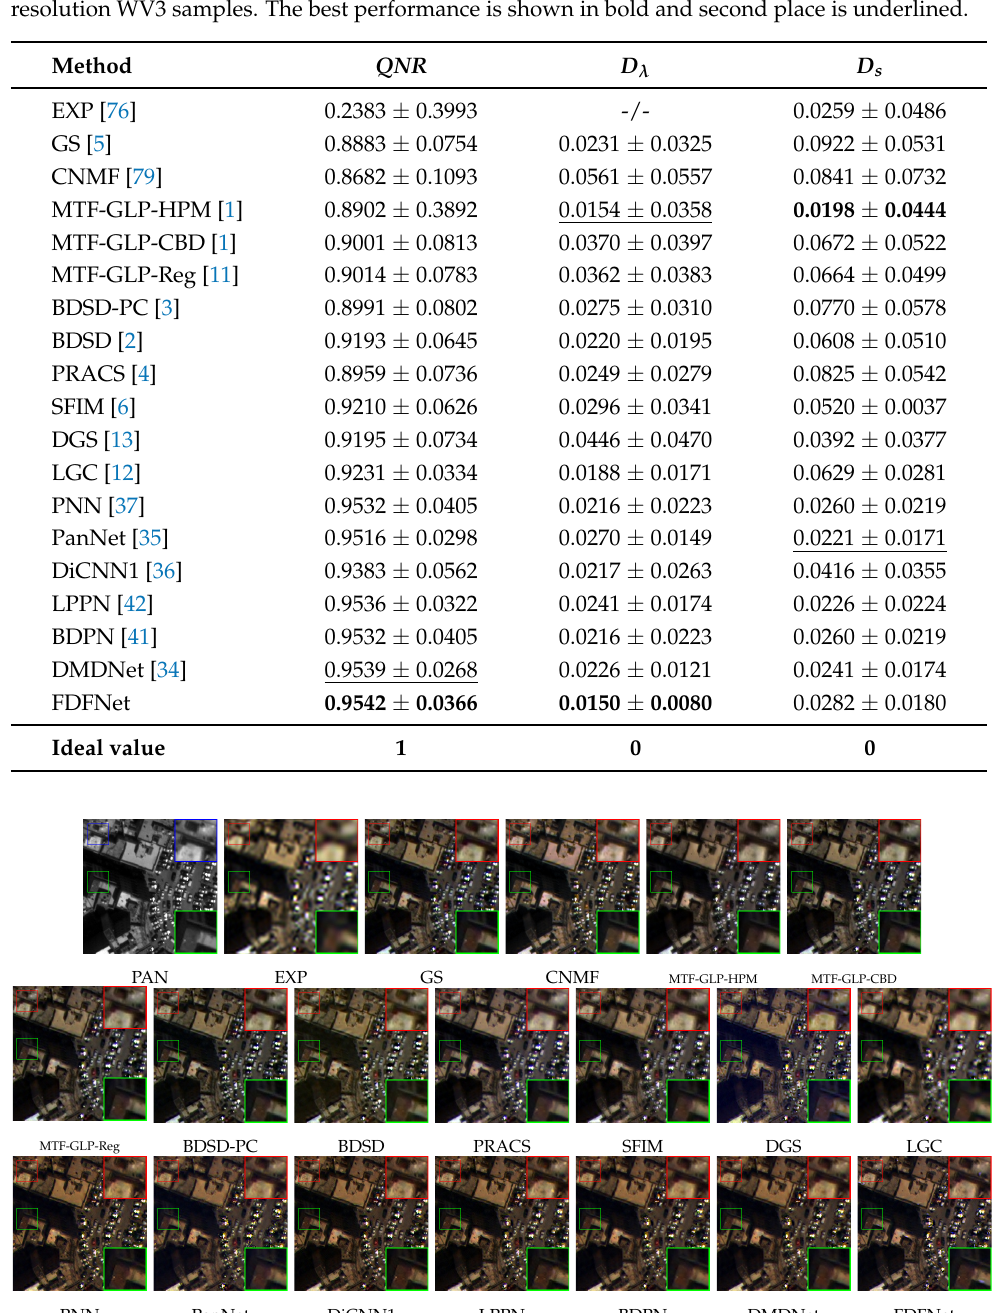
Table 5. The average quantification compared to the relative standard deviation (std) of 50 full- resolution WV3 samples. The best performance is shown in bold and second place is underlined.